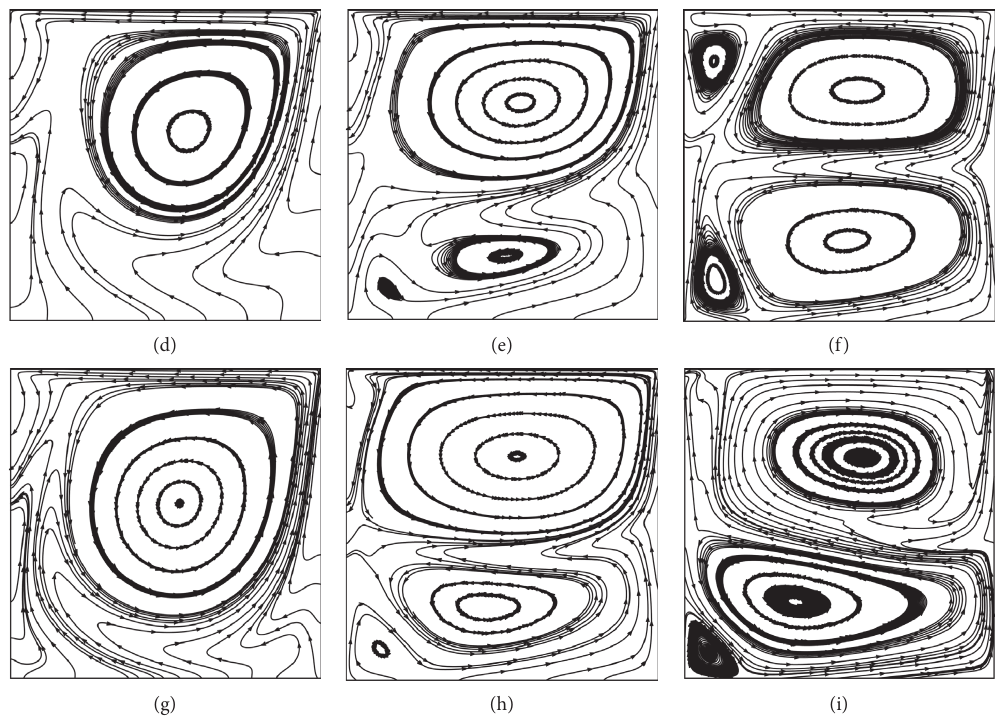
Figure 4: Simulated energy streamlines for different Re and Ri values. ( Re , Ri ) � (a) (100, 0.001), (b) (100, 1), (c) (100, 10), (d) (400, 0.001), (e) (400, 1), (f) (400, 10), (g) (1000, 0.001), (h) (1000, 1), and (i) (1000,